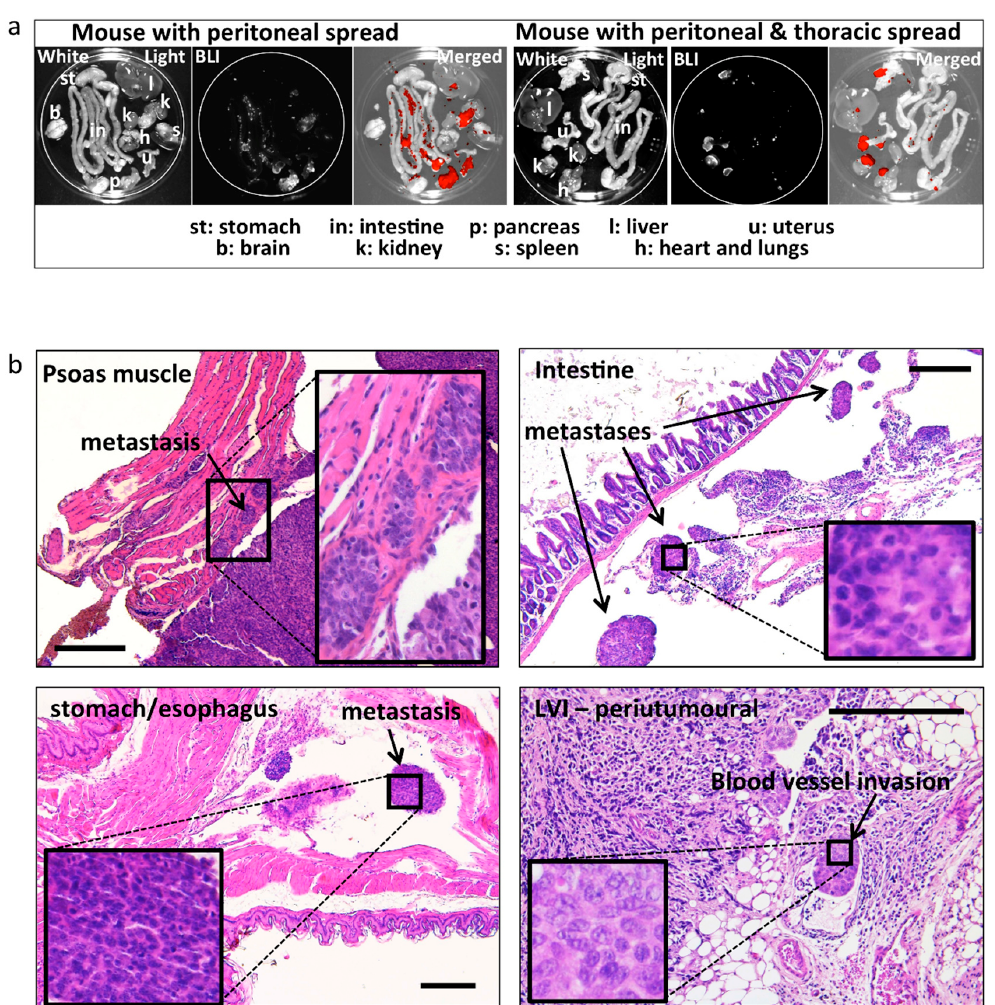
Figure 4. Ex-vivo BLI and histologically confirmed metastases. ( a ) Representative images of post mortem ex-vivo BLI used to assess the metastatic spread to different peritoneal and extra peritoneal organs. Left: example of spread restricted to peritoneal organs. Right: example of spread to the heart/lungs (thoracic cavity). Strong BLI signal (white in the BLI images and red in the merged images) was associated with fat tissue adjacent to peritoneal organs (spleen, kidneys). ( b ) Representative images and histologic confirmation of tumour spread to the psoas muscle, intestine, stomach/oesophagus, LVI, and infiltrating tumour cells in the (anatomic location/organs are indicated in the images). Bar scale: 300 μ m.